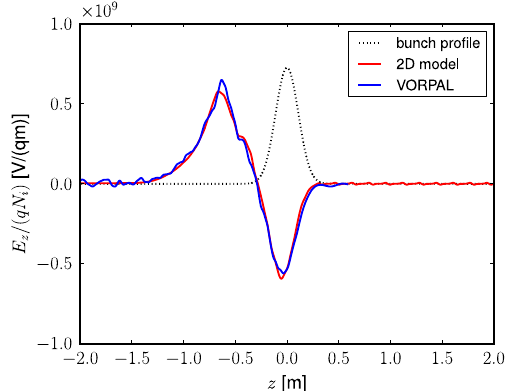
¼ en n ¼ 10 12 m (cid:2) 3 , is used to e , with e 0